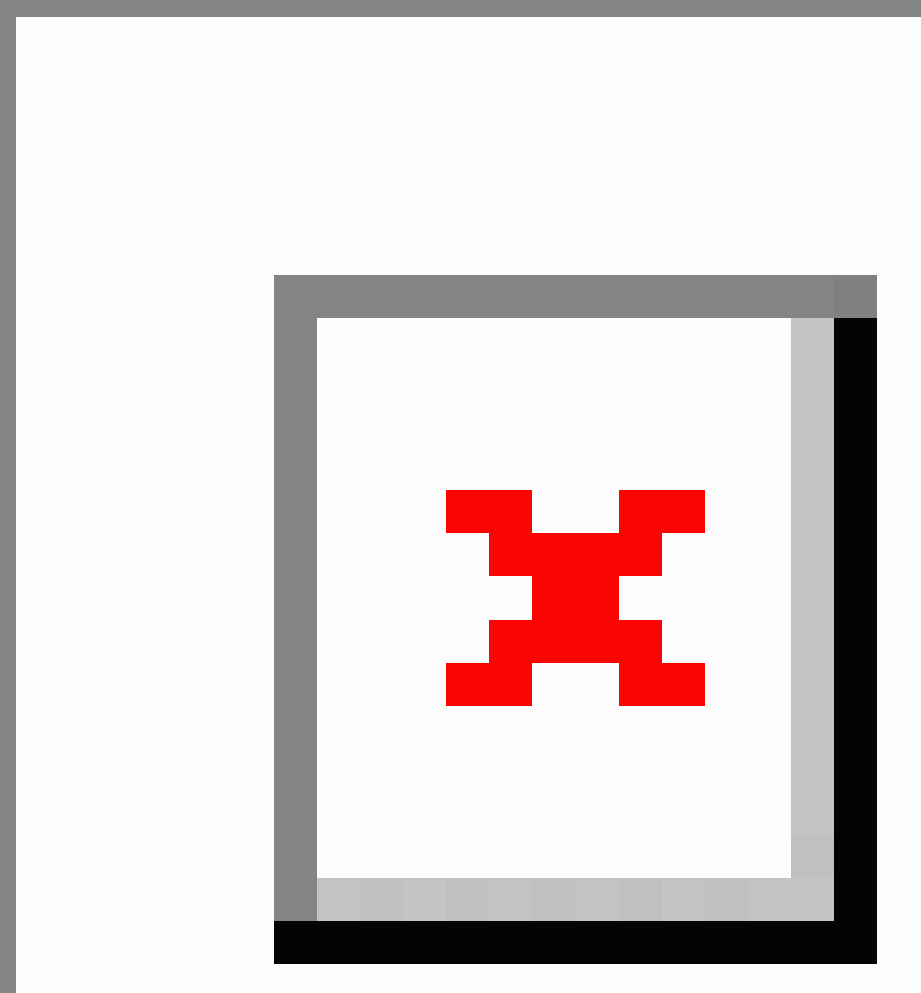
Figure 1. Time series comparisons between Tweet categories and ILI-ED